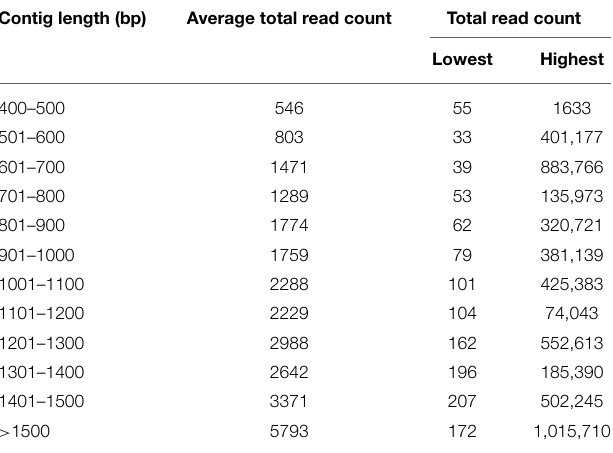
TABLE 2 | Statistics of mapped reads assembled into contigs in assembly 47 × 300